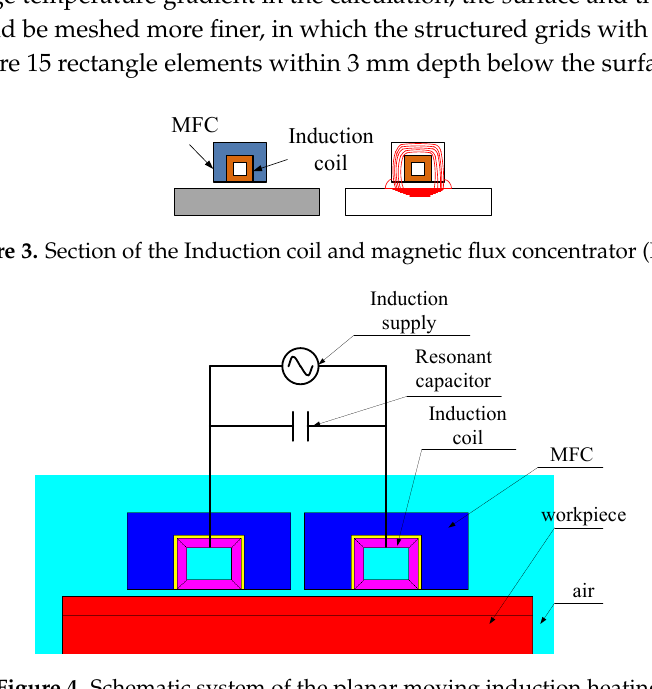
Figure 4. Schematic system of the planar moving induction